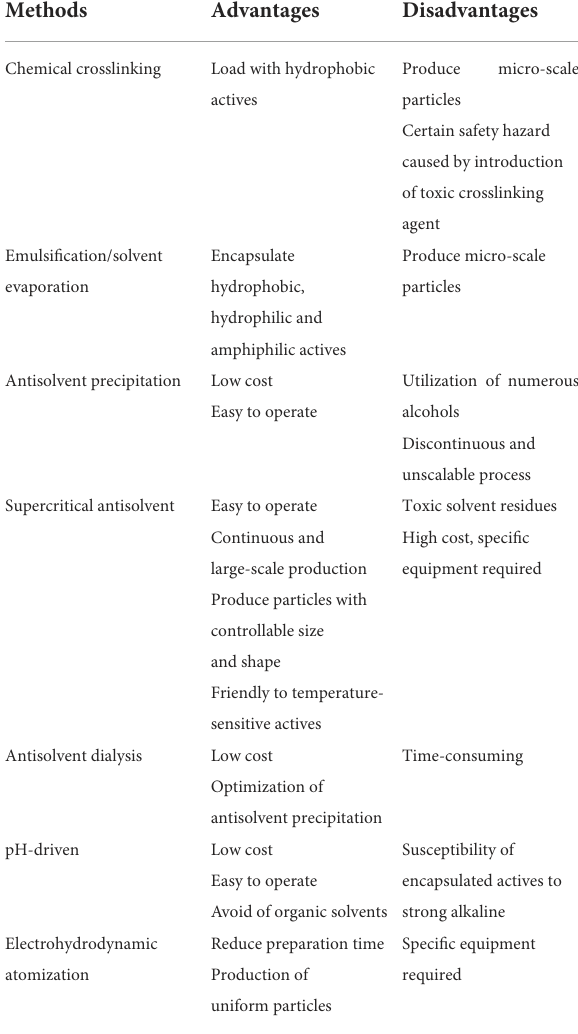
TABLE 1 Advantages and disadvantages of the methods for preparing zein